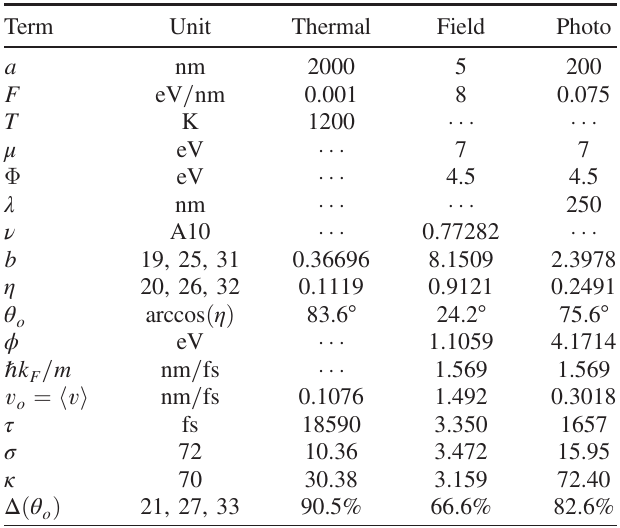
TABLE III. Parameters and values. Representative metallic parameters (nominally based on copper). Numbers in the “ Units ” column reference equations in the text. A dash “ (cid:1) (cid:1) (cid:1) ” denotes term not needed for η , σ , κ , or Δ